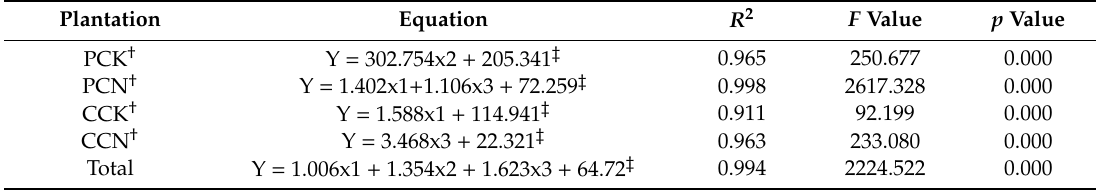
Table 6. Models of regressions between ecosystem C stock and its components in the four plantations.